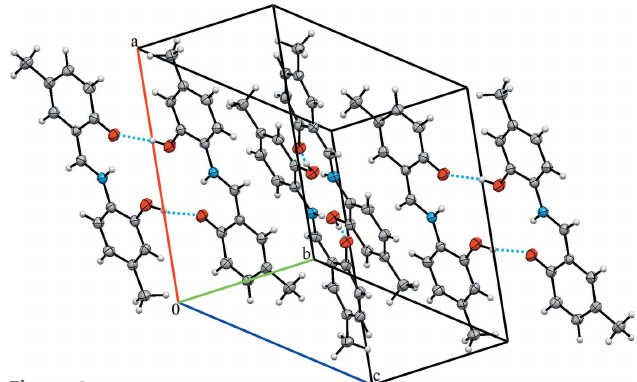
Figure 3 The crystal packing of the title compound.